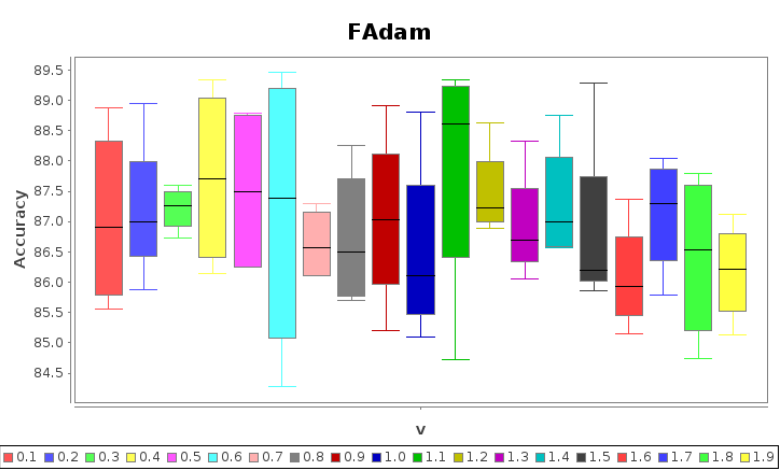
Figure 9. Experiment 2.2: FAdam cross-folding accuracies, K = 4 folds, ν ∈ [ 0.1,1.9 ]